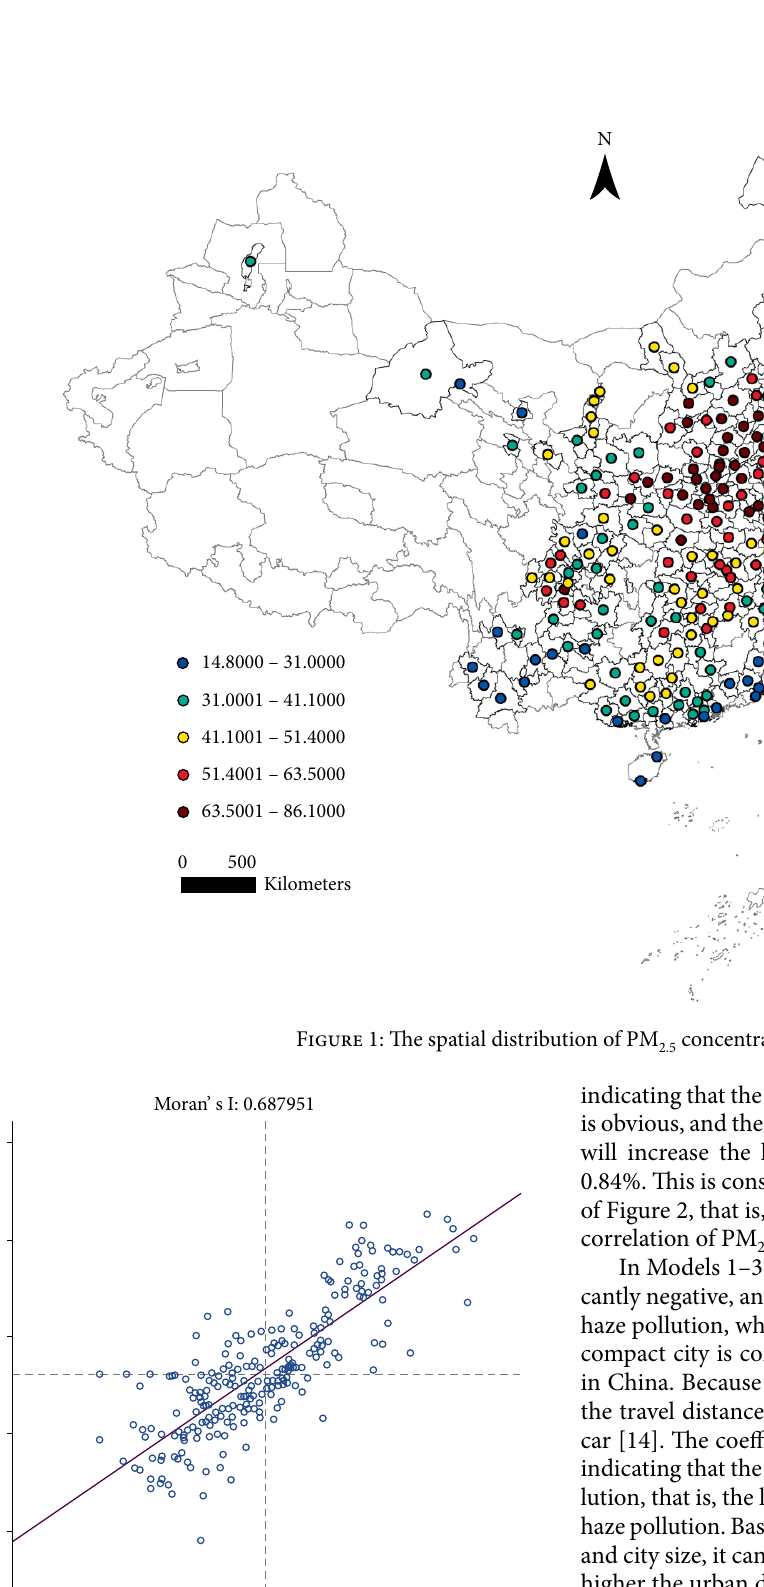
Figure 2: Moran’s I index scatter plot of PM